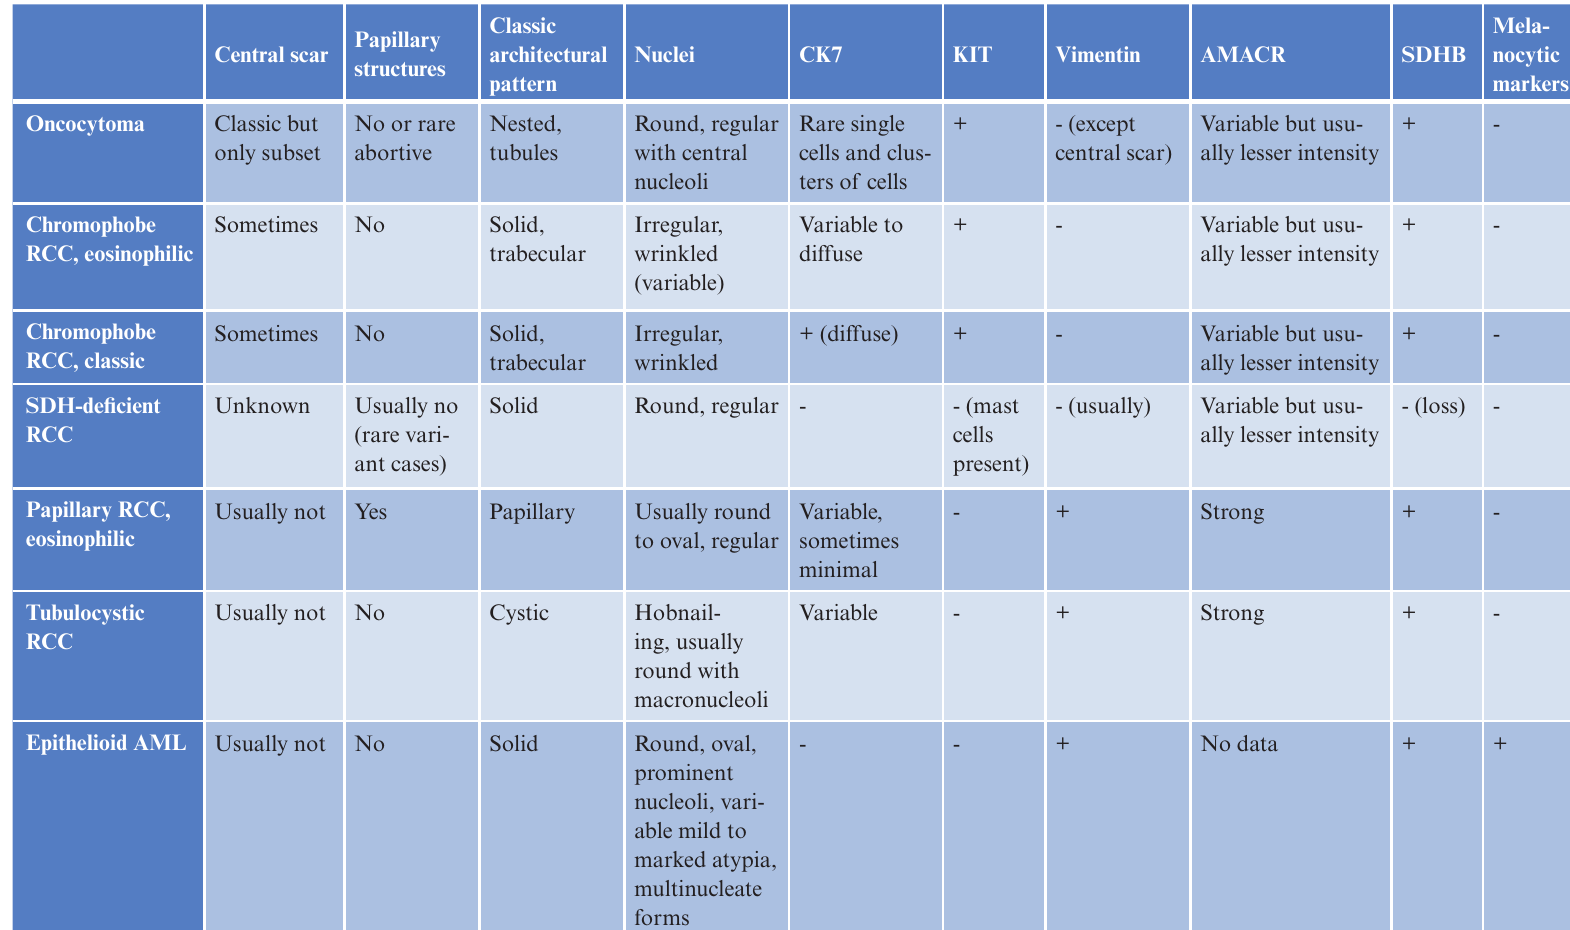
Table 1: Typical characteristics of oncocytoma and differential diagnostic